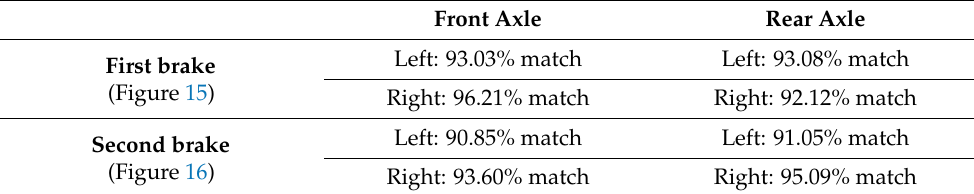
Table 3. Correlation coefficient for data comparison of brake forces for Figures 15 and 16. Front